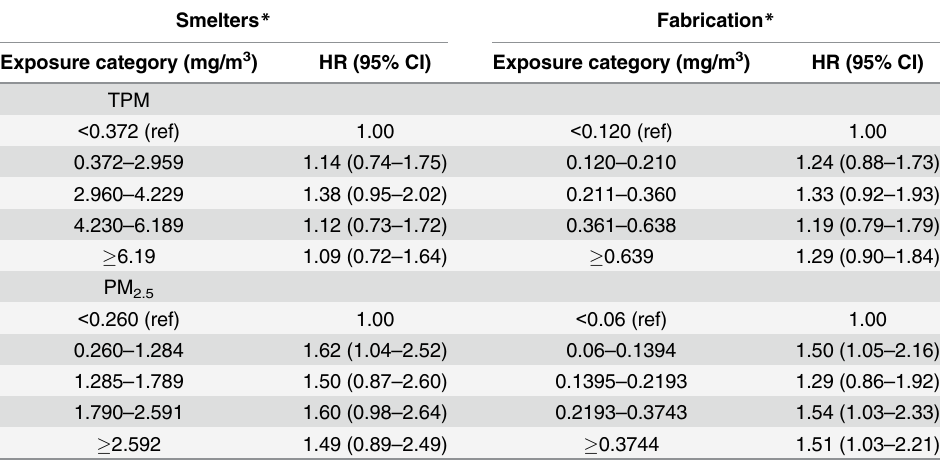
Table 3. Hazard Ratios (95% CI) for the risk of IHD associated with categorical exposures to TPM and PM 2.5 stratified by work process type. Smelters